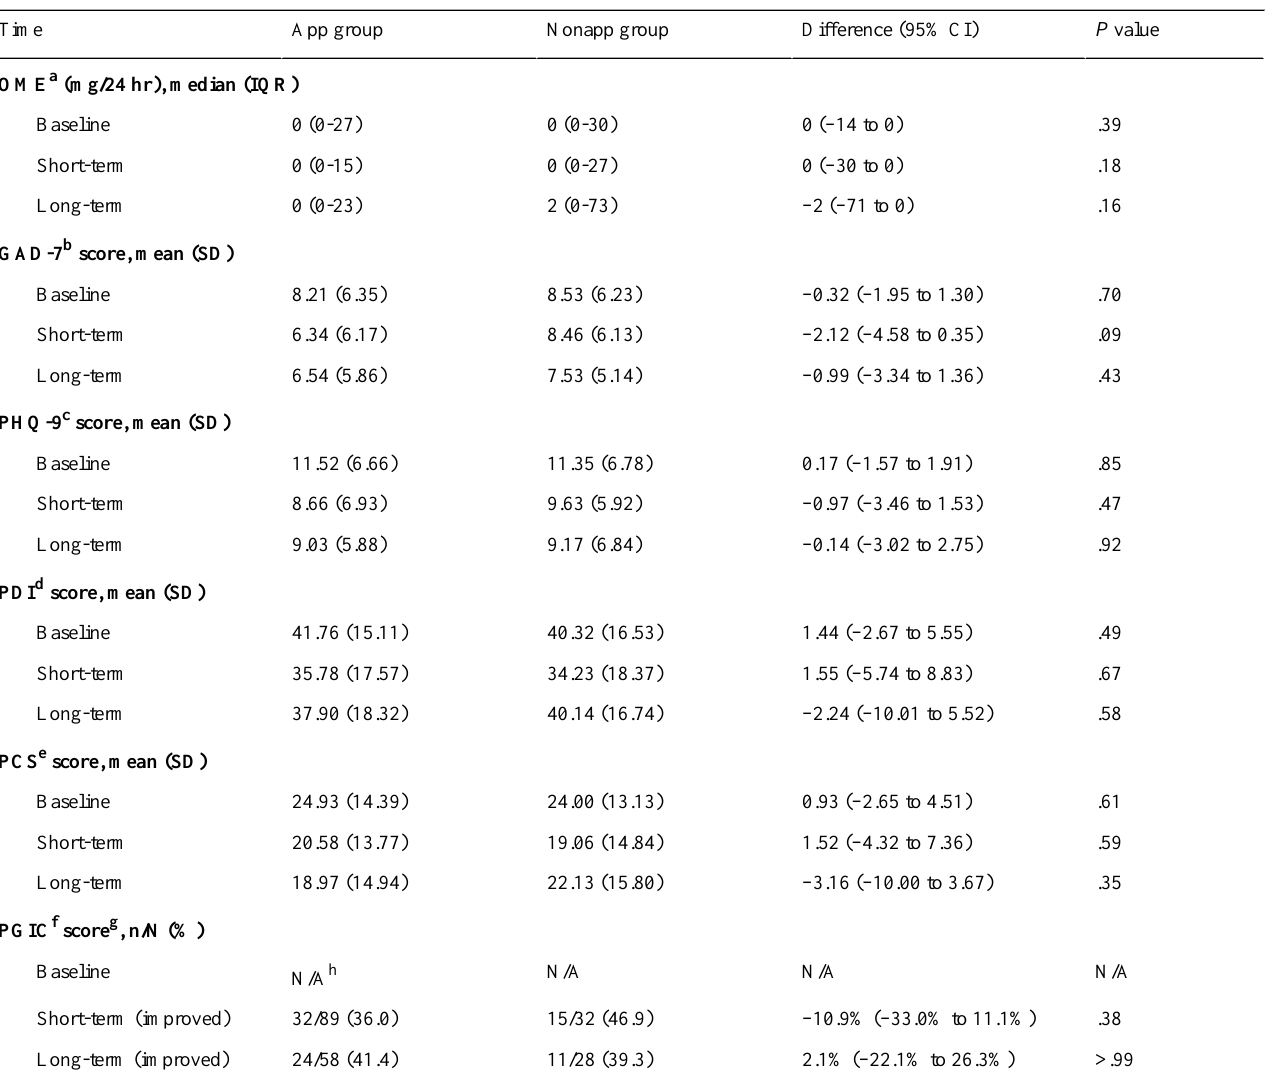
Table 4. Unadjusted outcomes stratified by time and group. The differences between the intervention and control groups are represented as absolute numbers with their 95% CIs, and 95% CI for OME used bootstrapped